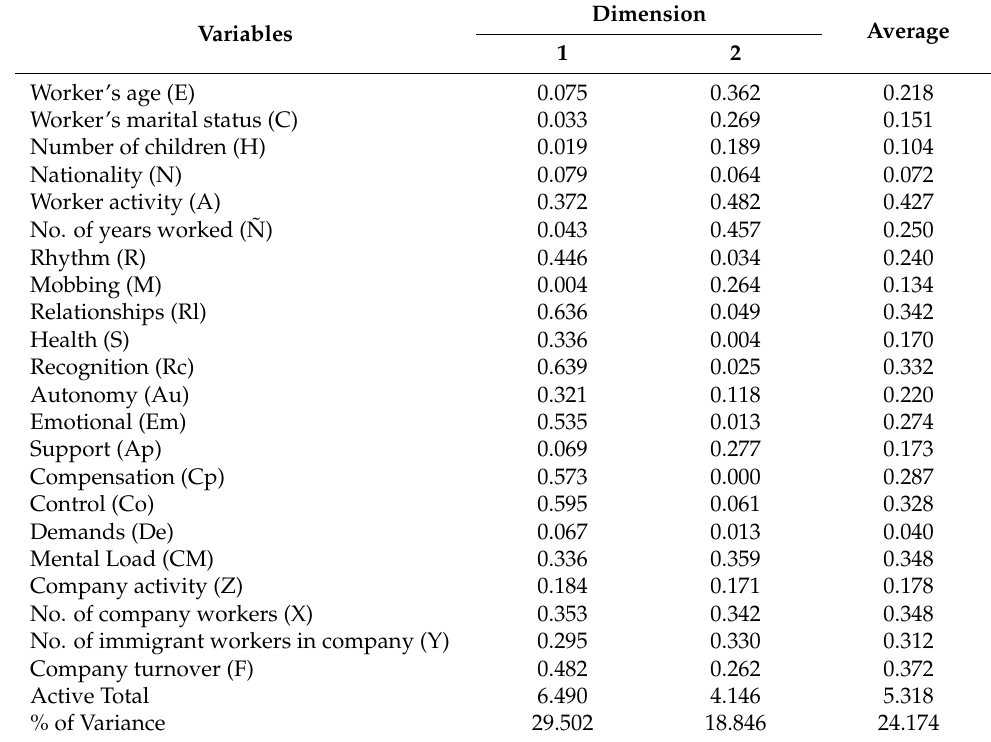
Table 5. Discrimination measures of the variables in the multiple correspondence